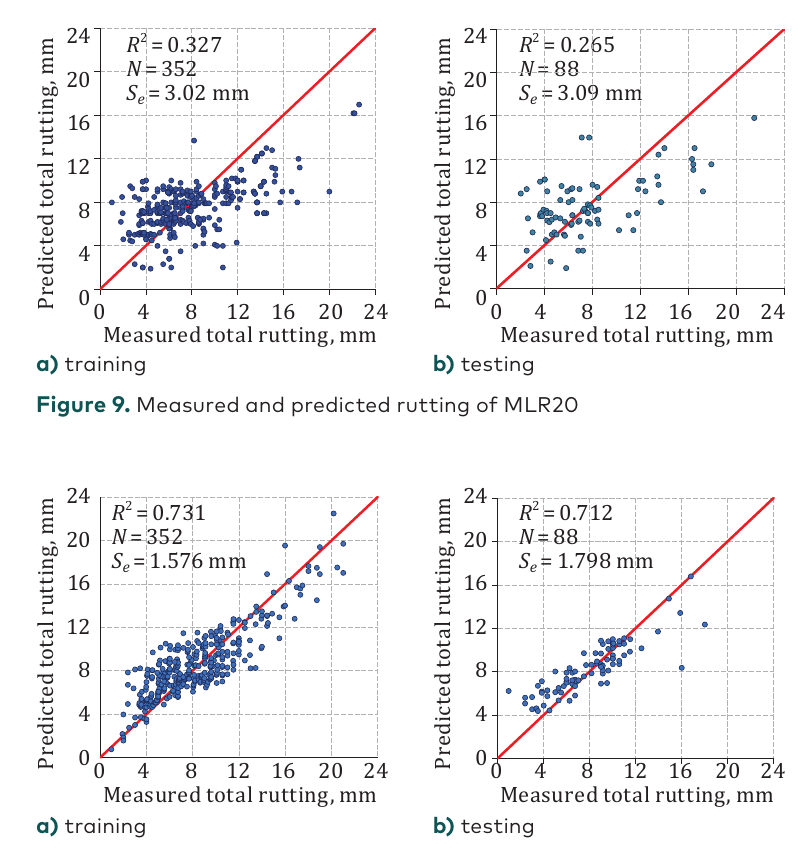
Figure 10. Measured and predicted rutting of MLR-pro